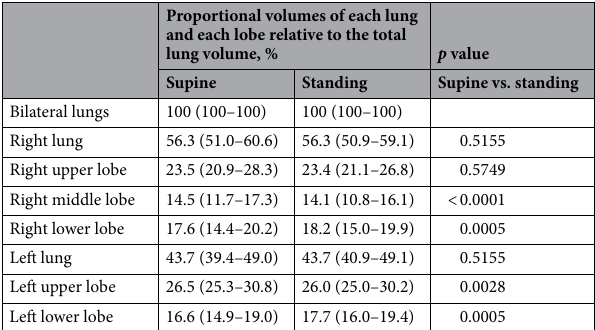
Table 3. Lung and lobe volumes relative to the total lung volume in supine and standing positions. Data are presented as medians (interquartile range).